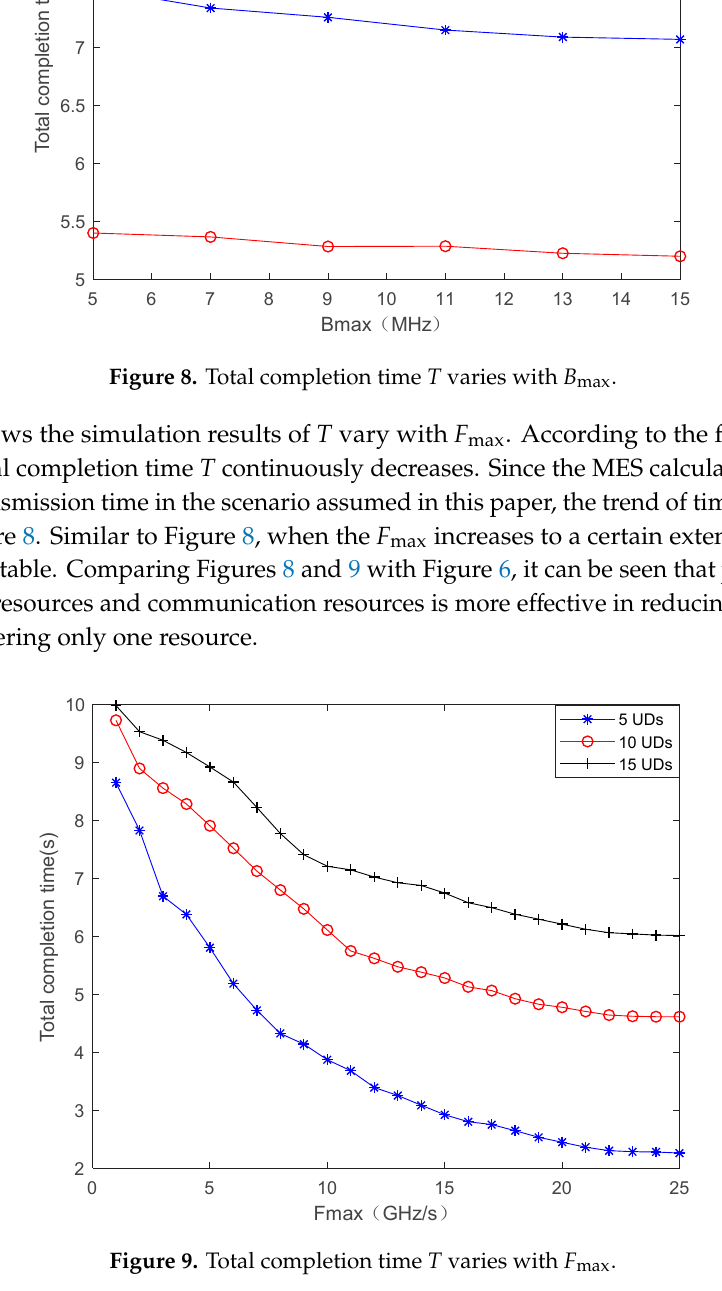
Figure 9. Total completion time T varies with F max